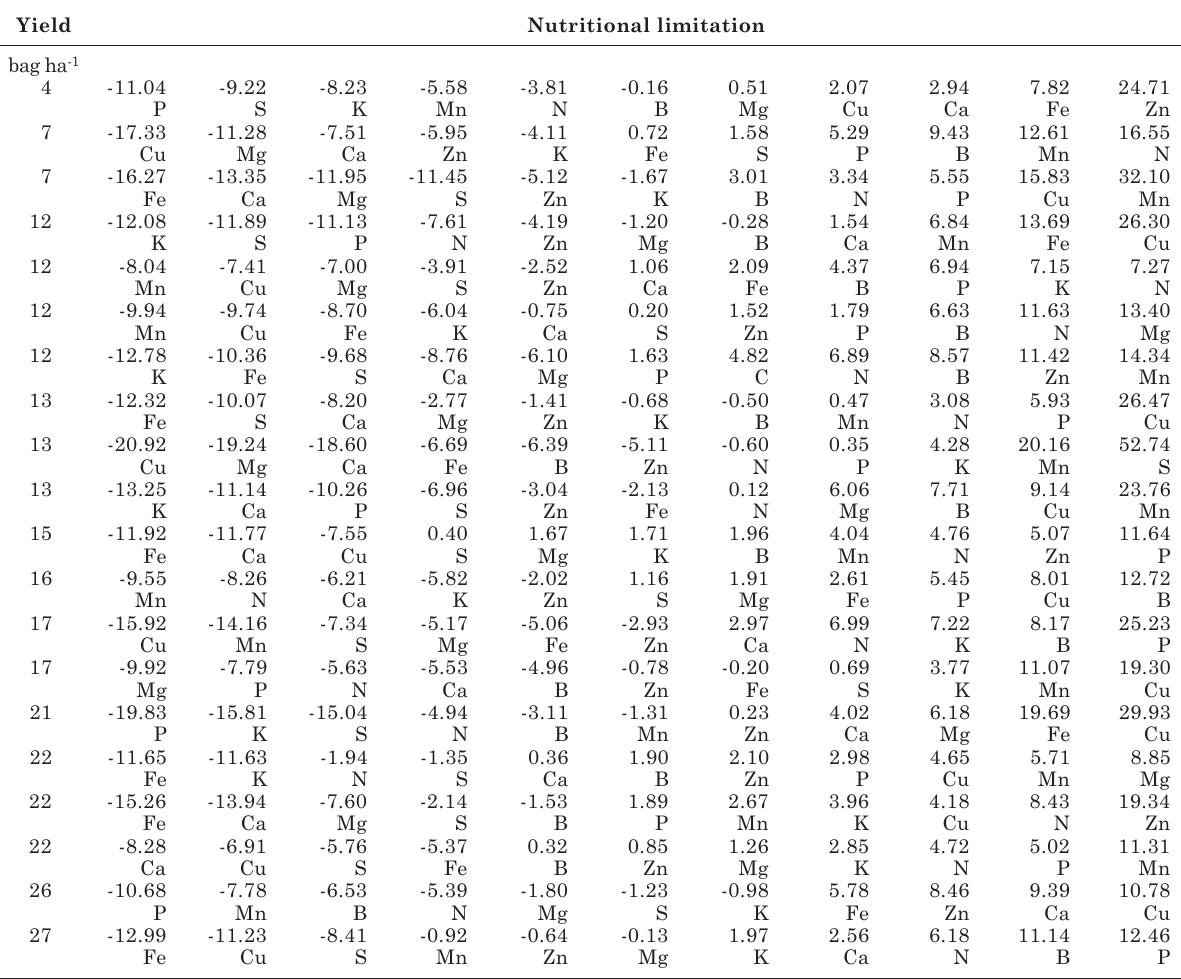
table 4. Classification of the nutritional limitation using the dris index for crops that did not coincide with the FRL